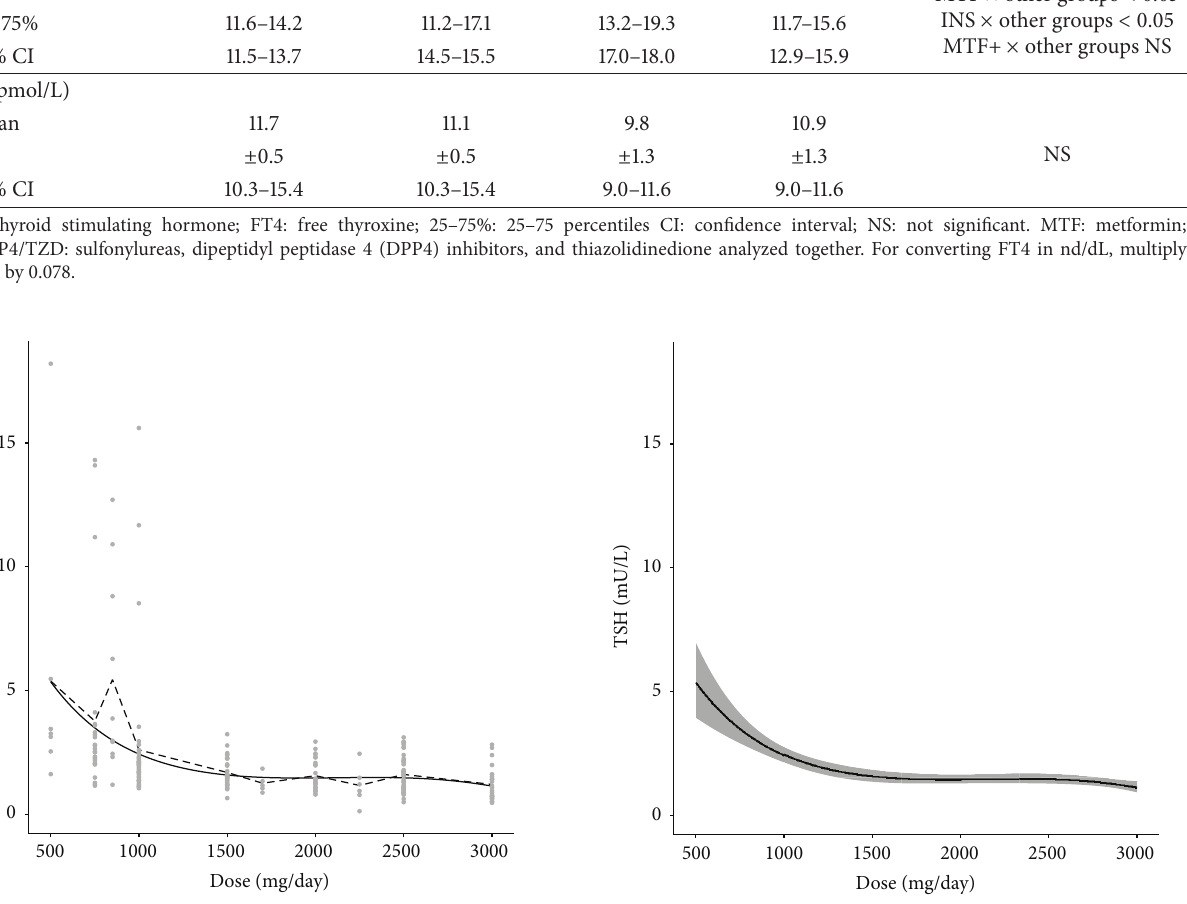
Figure 2: 95% confidence interval for the estimated TSH according to the MTF